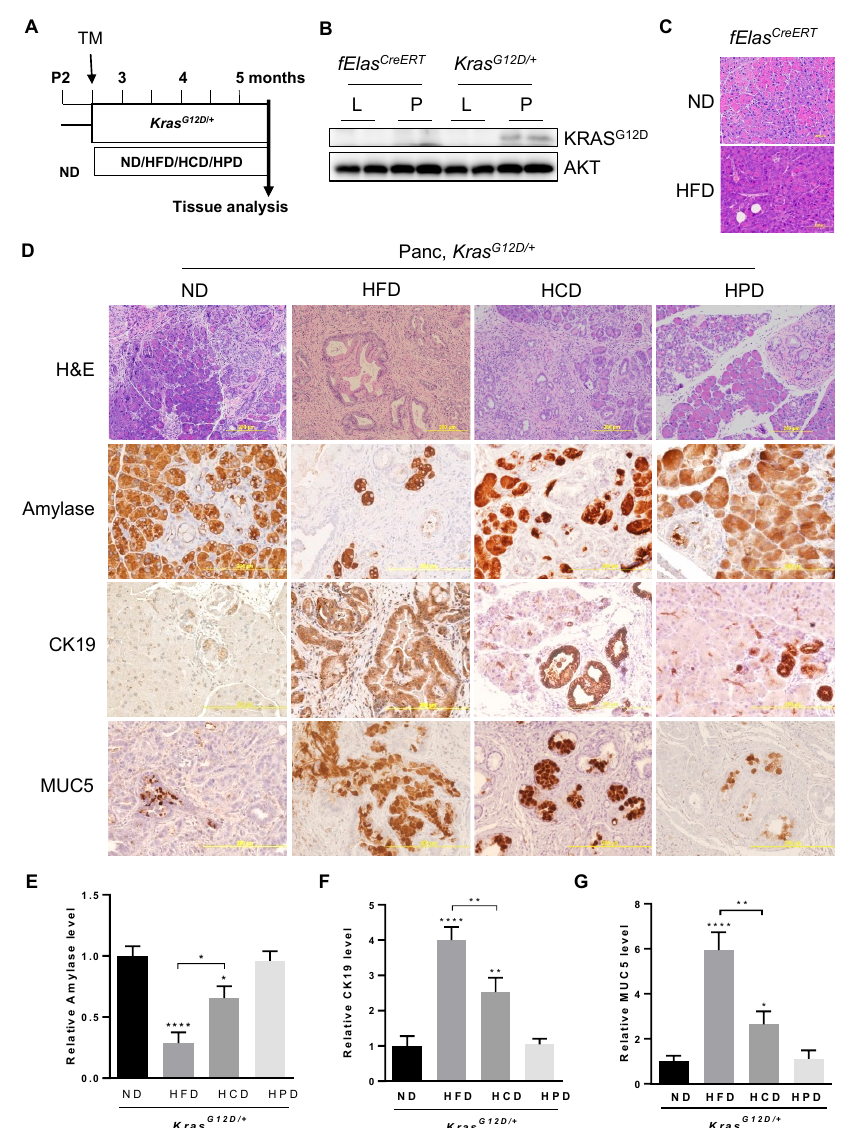
Figure 1. Effects of different macronutrient diets on oncogenic KRAS-mediated pancreatic neoplastic lesions. ( A ) Experimental timeline. KRAS G12D/+ mice were treated with Tamoxifen at the age of about 75 days for 5 days to allow the expression of KRAS G12D/+ specifically in adult acinar cells, separated into four groups fed an ND, HFD, HCD or HPD for 10 weeks, and then euthanized so that pancreatic pathological changes could be analyzed. ( B ) The protein levels of KRAS G12D in the pancreata and livers of KRAS G12D/+ and fElas CreERT mice. Original image of western blot can be found at Figure S1. ( C ) H&E staining of sections of representative pancreata from fElas CreERT mice fed an ND and an HFD under the same conditions as described in ( A ). Magnification: 200×. ( D ) H&E and IHC staining of paraffin sections of representative pancreata from KRAS G12D/+ mice under ND, HFD, HCD, or HPD treatment for 10 weeks, using antibodies against amylase, CK19, and Muc5. Magnifications: 100× for H&E and 200× for IHC. ( E – G ) Quantification of the above IHC stains with Fiji ImageJ software by measuring the integrated density (IOD) and the areas. *, **, and ****, p -value < 0.05, 0.01, and 0.0001, respectively.